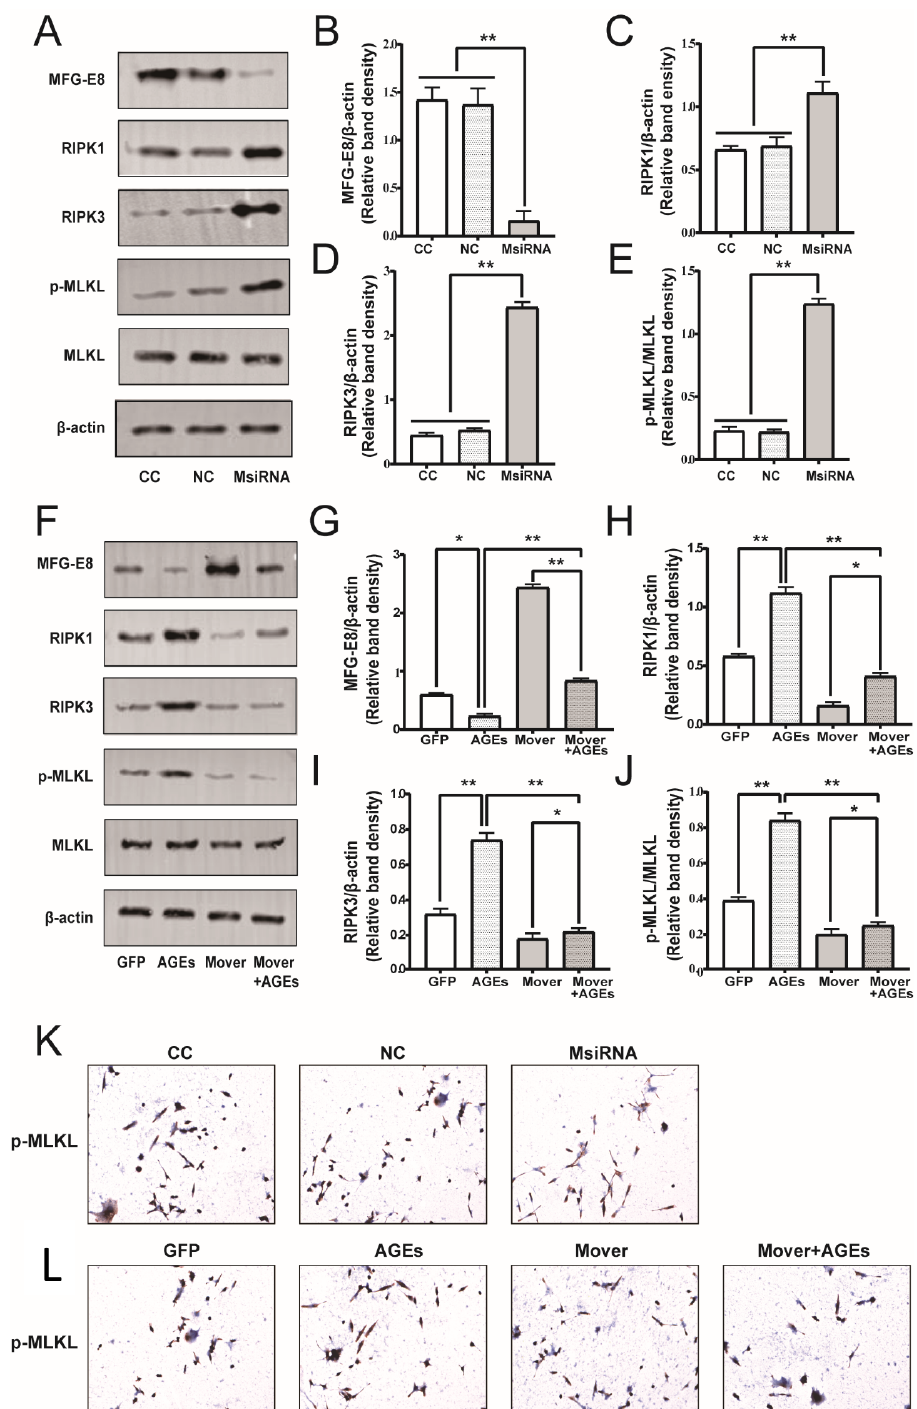
Figure 9. Effects of MFG-E8 on the necroptosis pathway related protein expression in STC-1 cells. ( A ) Effects of MFG-E8 siRNA on the expression of RIPK1-RIPK3-MLKL pathway. ( B – E ) Data were ex- pressed as the expression ratio of MFG-E8/ β -actin, RIPK1/ β -actin, RIPK3/ β -actin, p-MLKL/MLKL. ( F ) Effects of MFG-E8 overexpression on the expression of RIPK1-RIPK3-MLKL pathway. ( G – J ) Data were expressed as the expression ratio of MFG-E8/ β -actin, RIPK1/ β -actin, RIPK3/ β -actin, p-MLKL/MLKL. ( K , L ): ICC staining showed the protein level of p-MLKL-positive cells in MFG-E8 siRNA and overexpression group. Data were expressed as the means ± SD from three independent experiments. * p < 0.05, ** p <